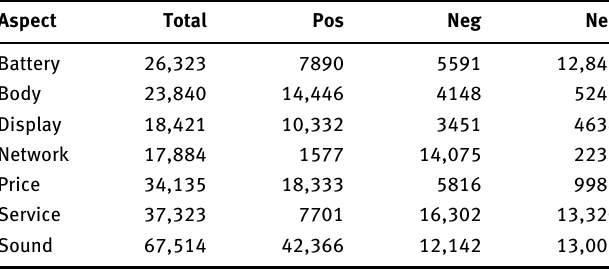
Table 4: Polarity Count for Various